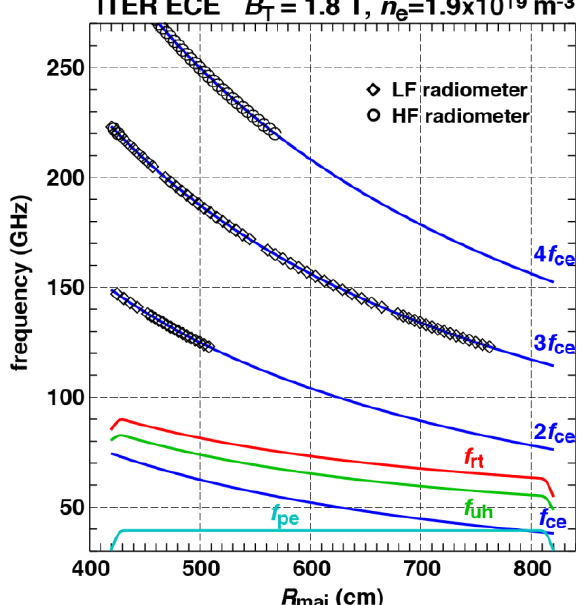
Fig. 3. Simulated frequencies and radial coverage by presently designed radiometers for 1.8 T ECE operation assuming recent METIS 0.5D kinetic profiles for Te and ne.